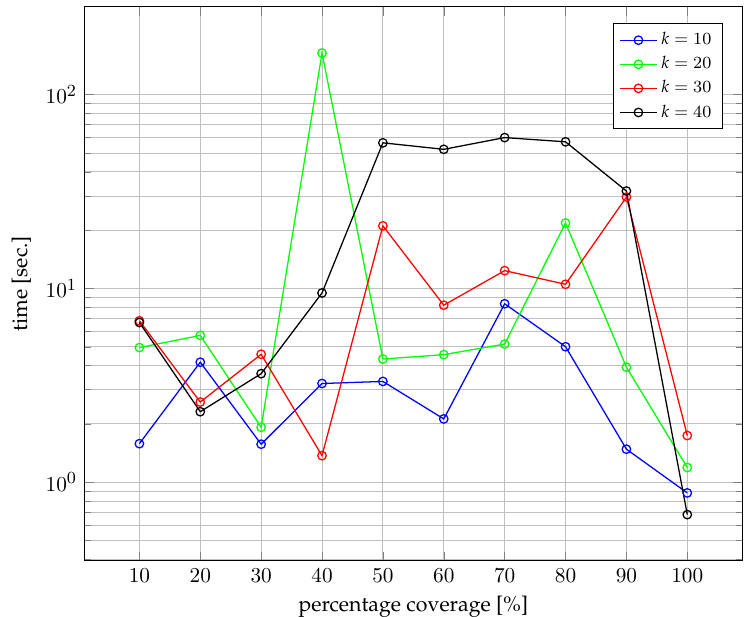
Figure 9. Computation time. Sampling frequency in a given pipe depends on flow and the size of the pipe.